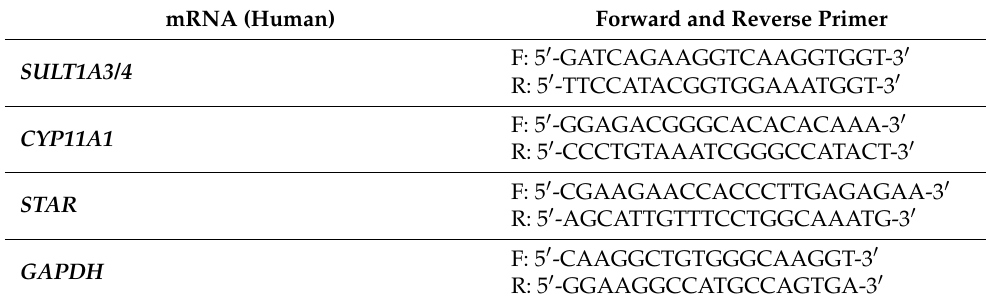
Table 1. Primer sequences used for RT-qPCR analysis. mRNA (Human) Forward and Reverse Primer